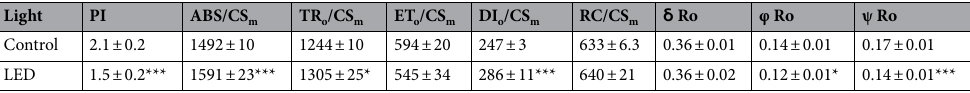
Table 2. Changes in the kinetics of chlorophyll a fluorescence in common buckwheat plants of cv. ‘Panda’ grown under different controlled-environment production systems. Control—solar light supplemented with HPS (High-Pressure Sodium) lamps; LED (Light-Emitting Diodes). Values represent means ( n = 20) ± SE. Values marked with stars differ from the control significantly according to the Student’s t test: * p < 0.05; ** p < 0.01; *** p < 0.001. ABS/CS m —energy absorption by antennas, DI o /CS m —energy dissipation from PSII, ET o /CS m —the energy used for electron transport, PI—performance index of PSII, RC/CS m —number of active reaction centers, TR o /CS m —excitation energy trapped in PSII, δ Ro—efficiency with which an electron can move from the reduced intersystem of electron acceptors to the PSI end electron acceptors, ψ Ro—probability, at time 0, that a trapped exciton moves an electron into the electron transport chain beyond Q A − , φ Ro— quantum yield of electron transport from Q A− to the PSI end electron acceptors.